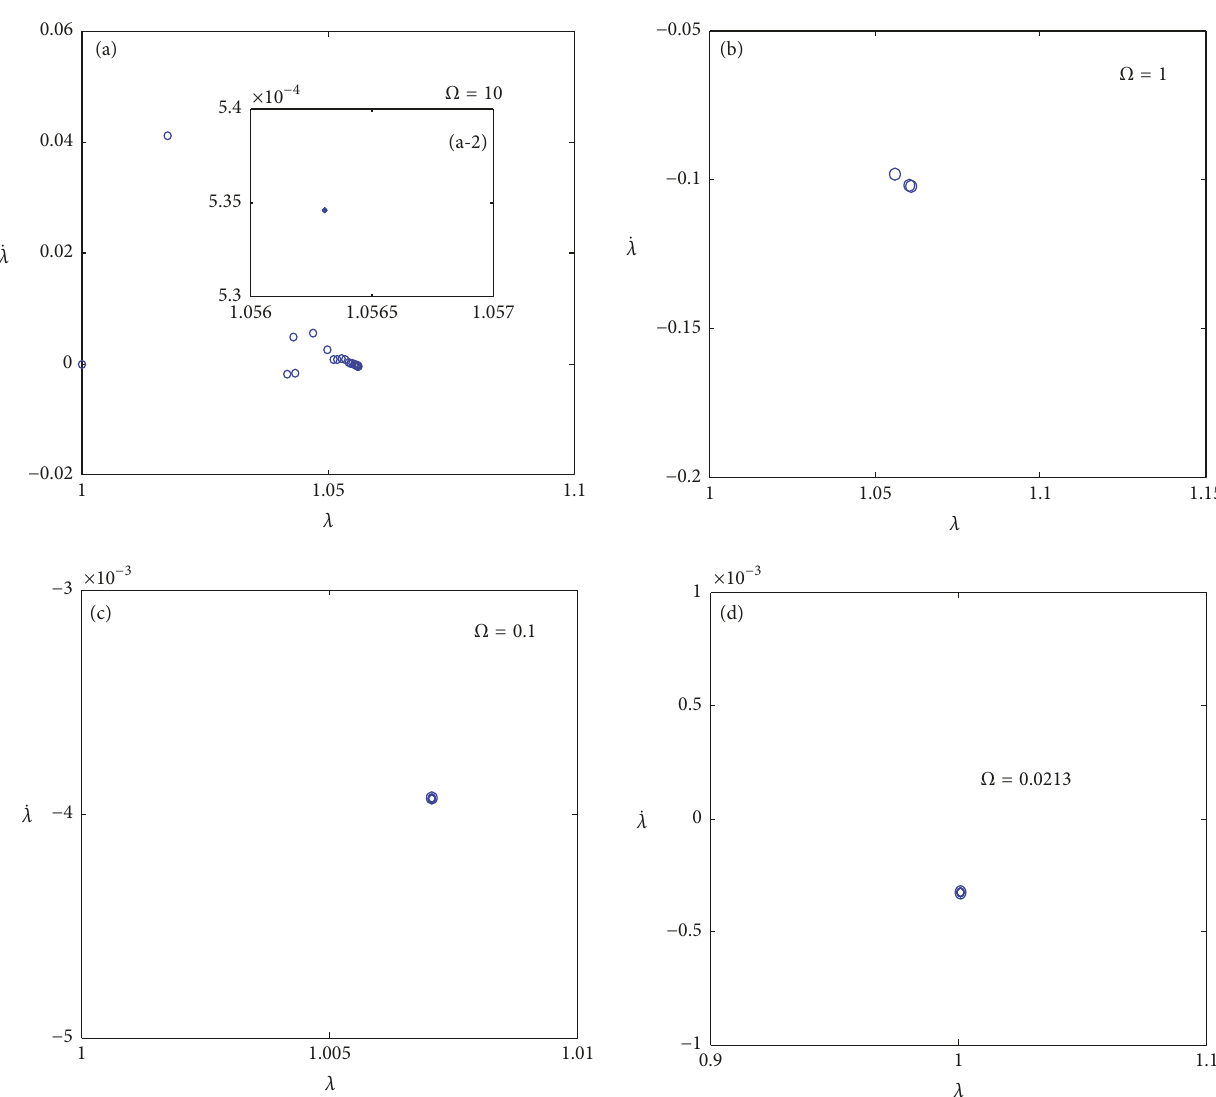
Figure 8: Poincar´e map for the oscillation under a cyclic electric load with different dimensionless frequencies (a) Ω = 10 , (b) Ω = 1 , (c) Ω = 0.1 , and (d) Ω = 0.0213